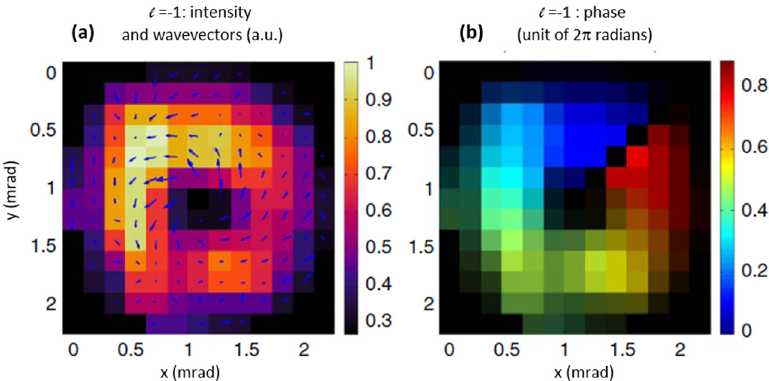
Figure 11. Intensity ( a ) and wavefront map ( b ) for the l = − 1 mode of the 16th high-harmonic order emission (adapted from [50]). emission (adapted from